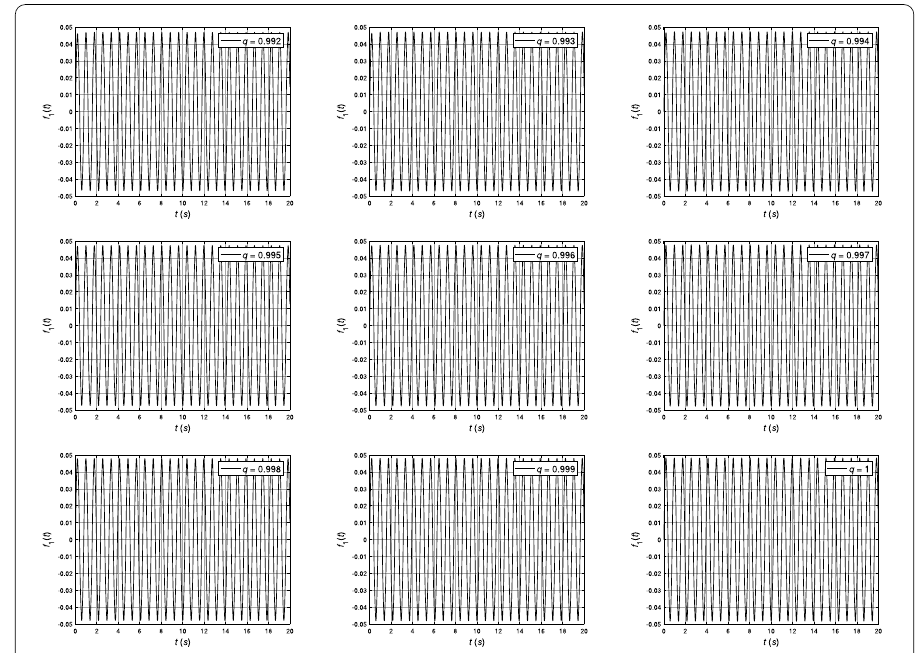
Figure 7 The state variable f 1 ( t ) of the controlled system (35) for q = 0.992,0.993,0.994,0.995,0.996,0.997, 0.998,0.999,1